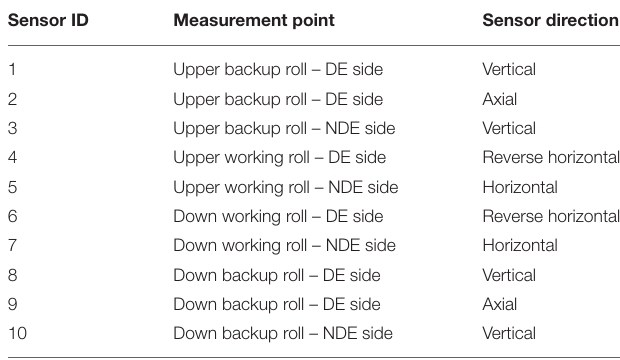
TABLE 3 | The installed